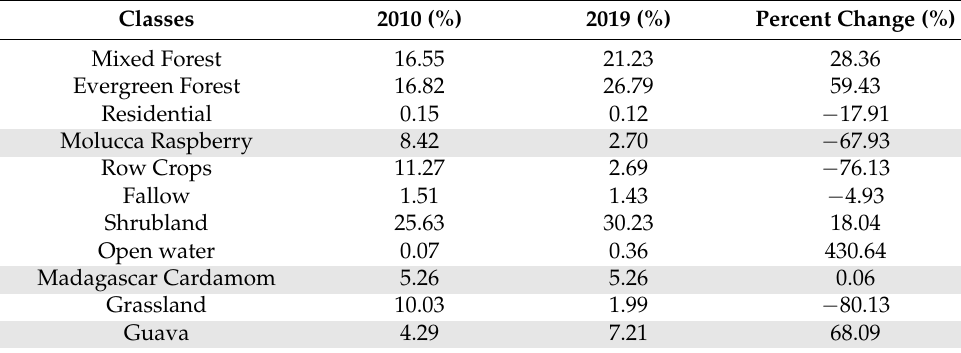
Table 7. Percentage of classes within the ZOP, a 100 m buffer zone that borders the BNR. Invasive forest cover types are